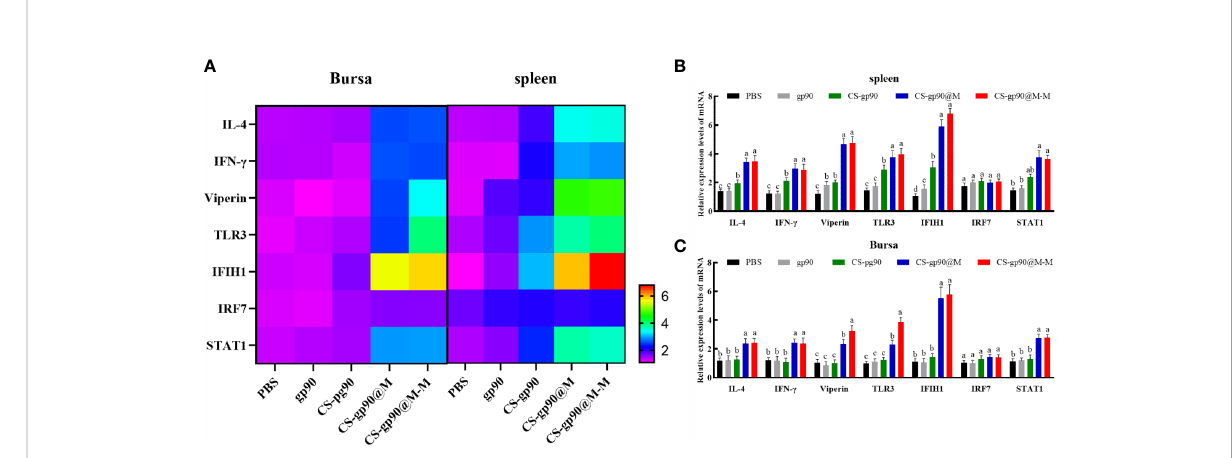
FIGURE 5 Effect of CS-gp90@M-M NPs on the expression of immune-related genes in the bursa and spleen of chicks. (A) Heatmap of gene expression in the bursa and spleen. In the lower right corner, the purple color indicates low expression change and the red color indicates high expression change. (B, C) Immune-related gene expression levels in the bursa and spleen. The different letters (a – c) designated as statistically signi fi cant differences ( P<0.05